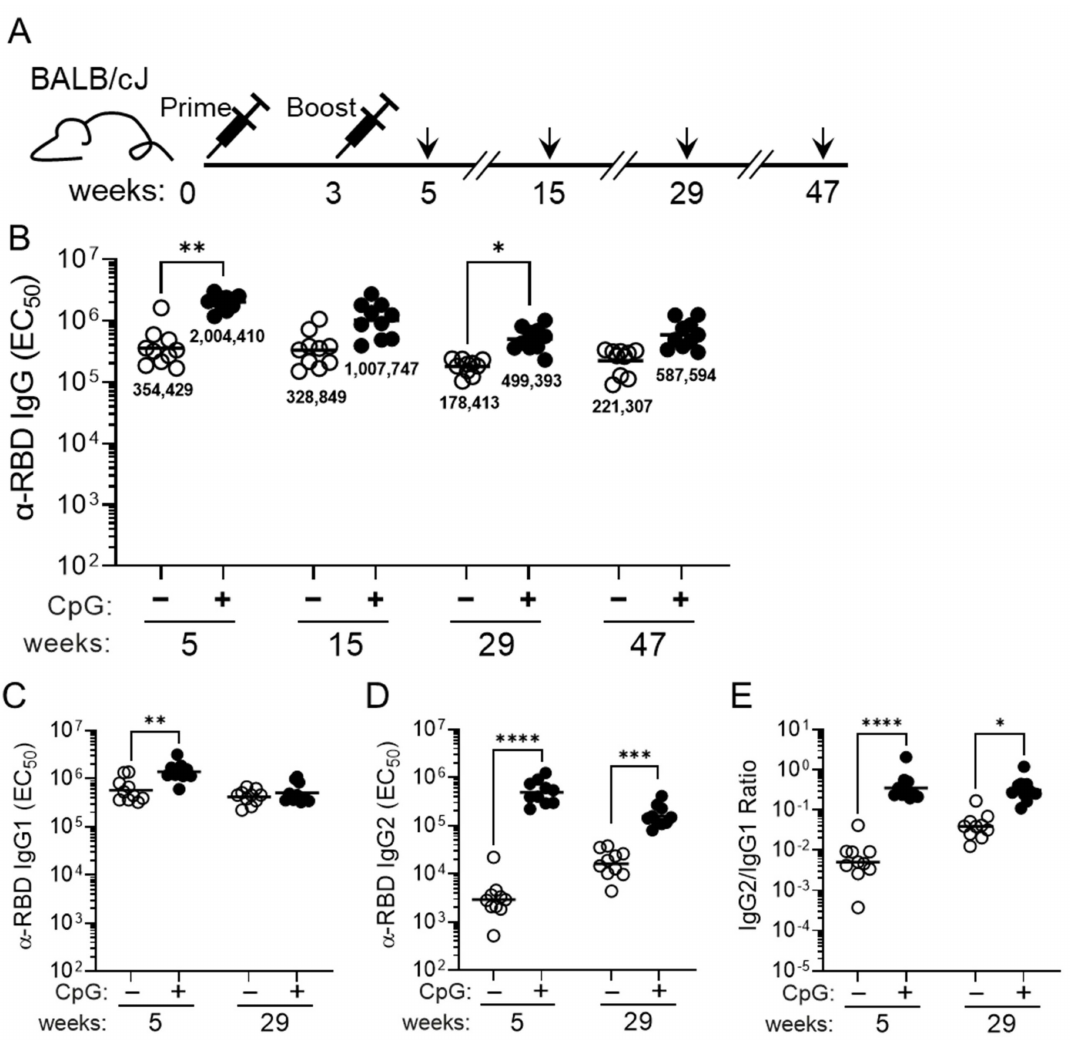
Figure 3. Immunization of mice with 3 µ g of MT-001 antigen in Alhydrogel with or without the TLR-9 agonist co-adjuvant, CpG ODN1826. ( A ) Schematic illustrating the MT-001 prime-boost regimen and bleeding schedule for 8–10-week-old female BALB/cJ mice ( n = 10). ( B ) RBD-specific IgG binding titers were assessed in mice immunized with 3 µ g MT-001 adjuvanted with 500 µ g Alhydrogel only ( − , open circles) or with 500 µ g Alhydrogel plus 20 µ g CpG ODN1826 (+, closed circles). Binding antibody responses are displayed at 5, 15, 29, and 47 weeks post-primary immunization. The balanced Th1/Th2 response resulting from the addition of CpG ODN1826 is evidenced by increased RBD- specific IgG1 ( C ) and IgG2 ( D ) antibody titers. This corresponded to an increased ratio of IgG2 to IgG1 antibody levels in CpG ODN1826-adjuvanted animals ( E ). Each circle (open or solid) represents the half-maximal titer for each serum sample averaged across at least three independent ELISAs. Horizontal bars indicate geometric mean titers per dose. p values reflect unpaired t tests between groups (* p < 0.05; ** p < 0.01; *** p < 0.001; **** p <